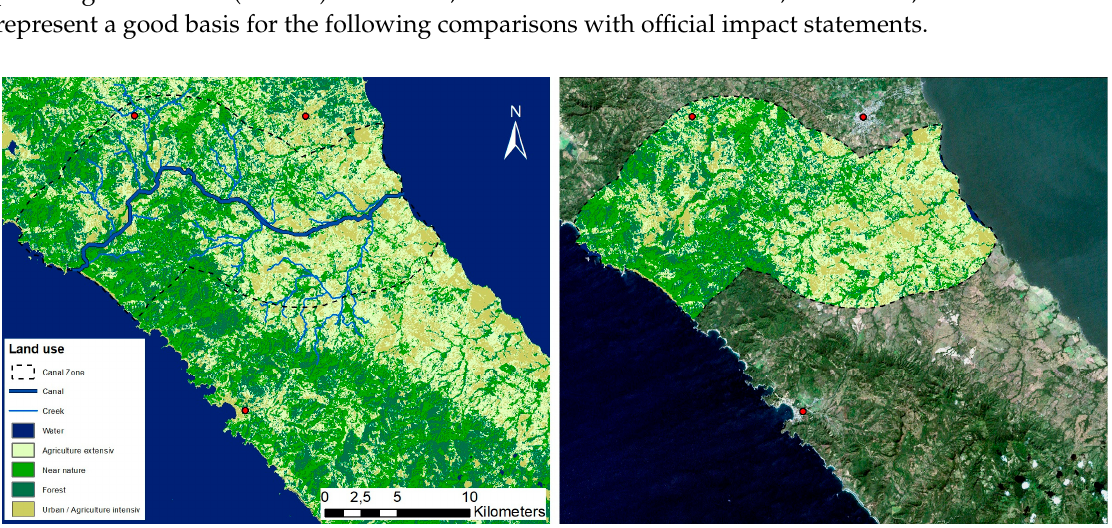
Figure 5. Results of land use classification ( left ), results of land use classification in the West Canal Segment Zone with an RGB image for areas outside of the canal zone (Landsat 7-Data) ( right ).